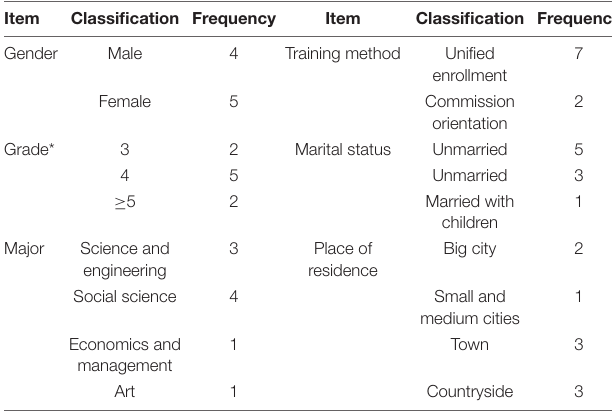
Grade*: the school system of doctoral students in different universities is different, generally 3–5 years, but can also be extended for 1–2 years.